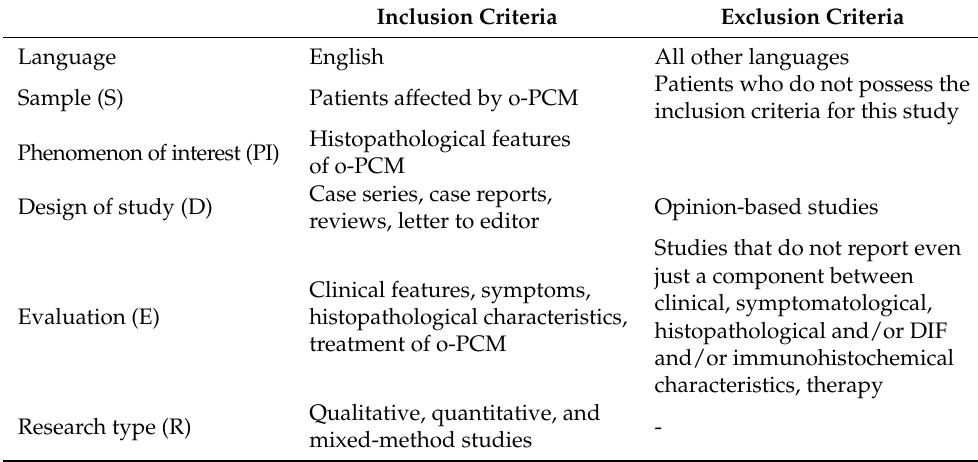
Table 1. Inclusion and exclusion